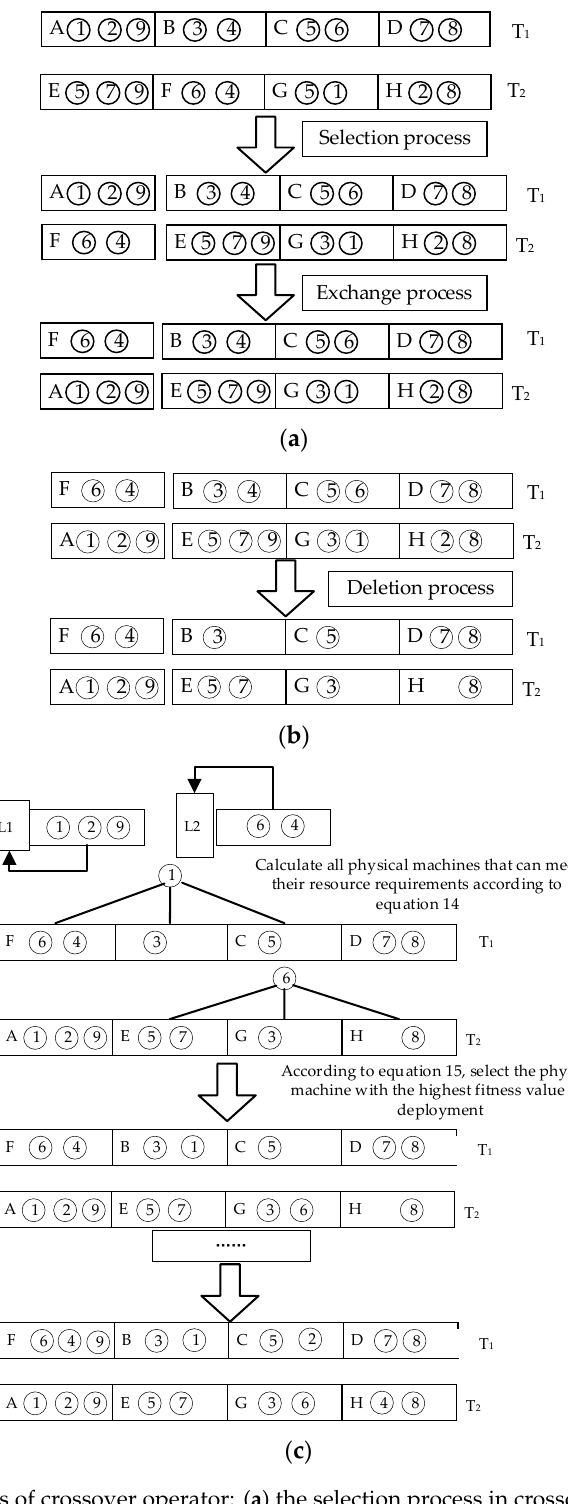
Figure 4. The process of crossover operator: ( a ) the selection process in crossover operation; ( b ) the deletion process in crossover operation; ( c ) the re-add process in crossover operation.